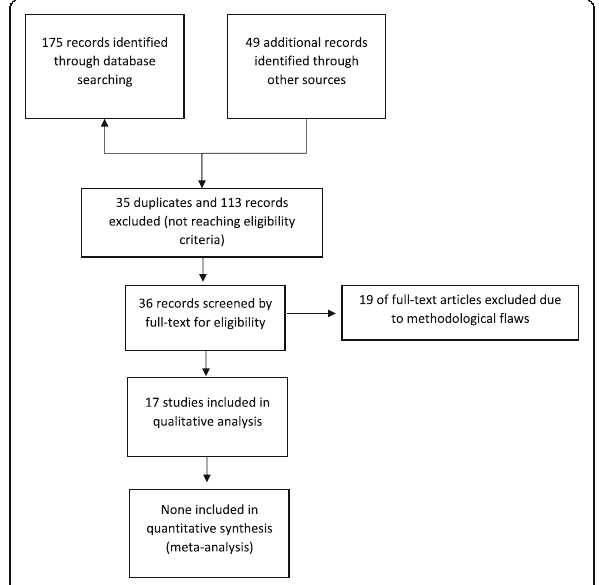
Fig. 1 Flow chart of the studies selection process during the systematic